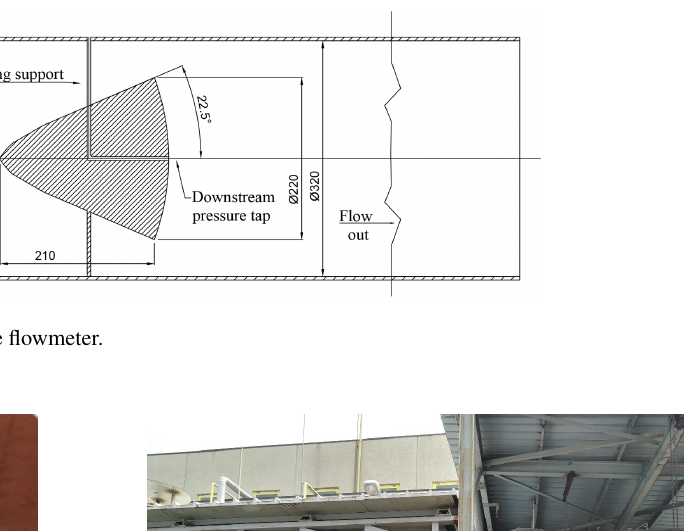
Figure 1. Schematic view of the original cone flowmeter, with the upstream and downstream pressure taps.